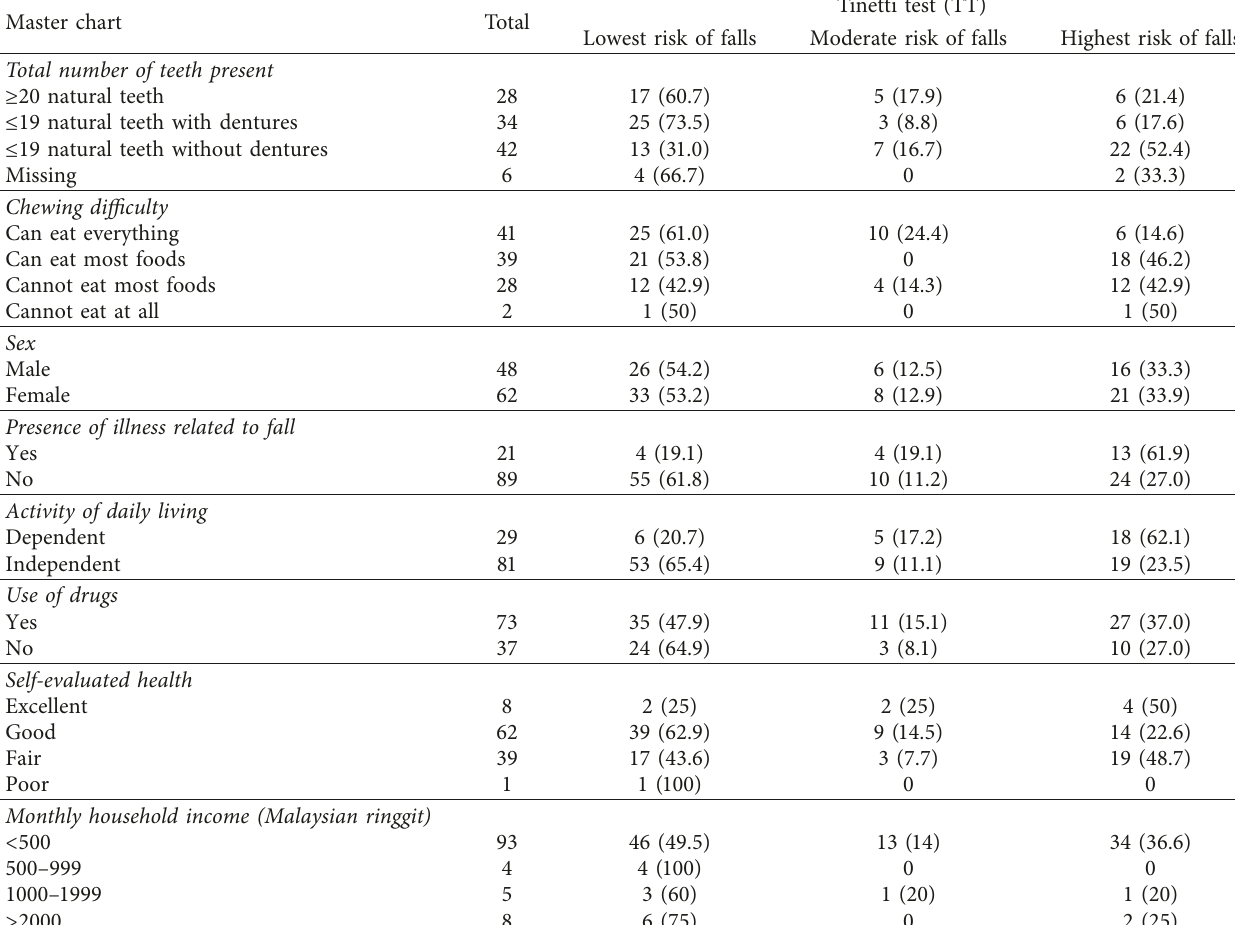
Table 1: Master chart of number of teeth present and covariates in relation to the risk of